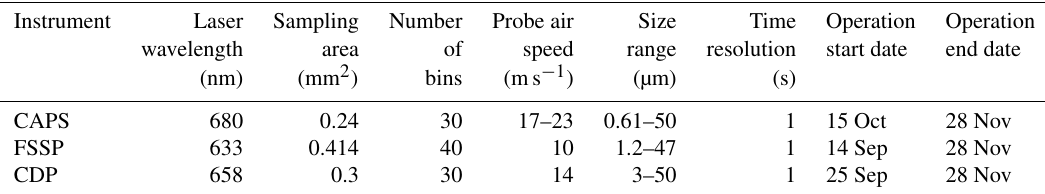
Table 1. Instruments, wavelengths (nm), sampling area (mm), number of bins, probe air speed (ms − 1 ) , size range (µm), time resolution (s), and operation starting and ending date are presented.